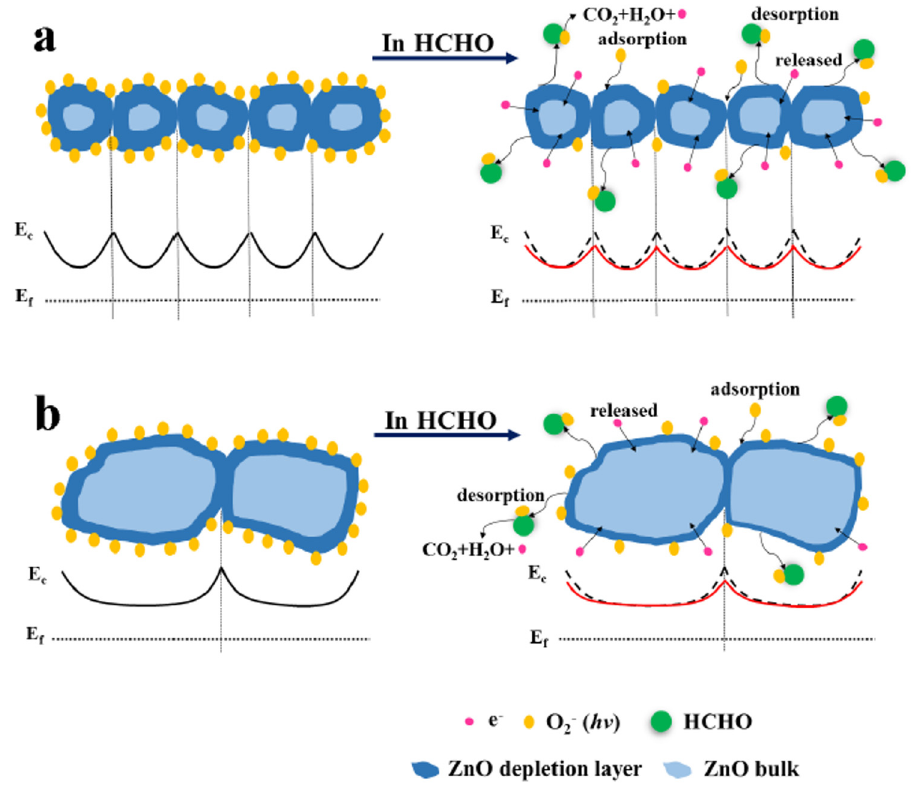
Figure 20: Gas sensing mechanism of ZnO nano fi bers under UV illumination: ( a ) ZnO nanoplates and ( b ) ZnO nano fl owers in the presence of HCHO. Reproduced with permission from Elsevier [ 396 ]